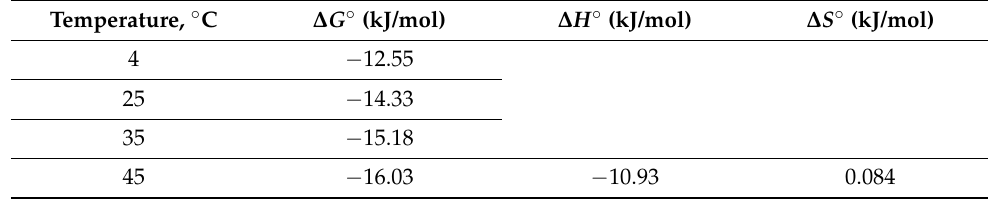
Table 4. Thermodynamic parameters of E2-NP/BC-NFs.